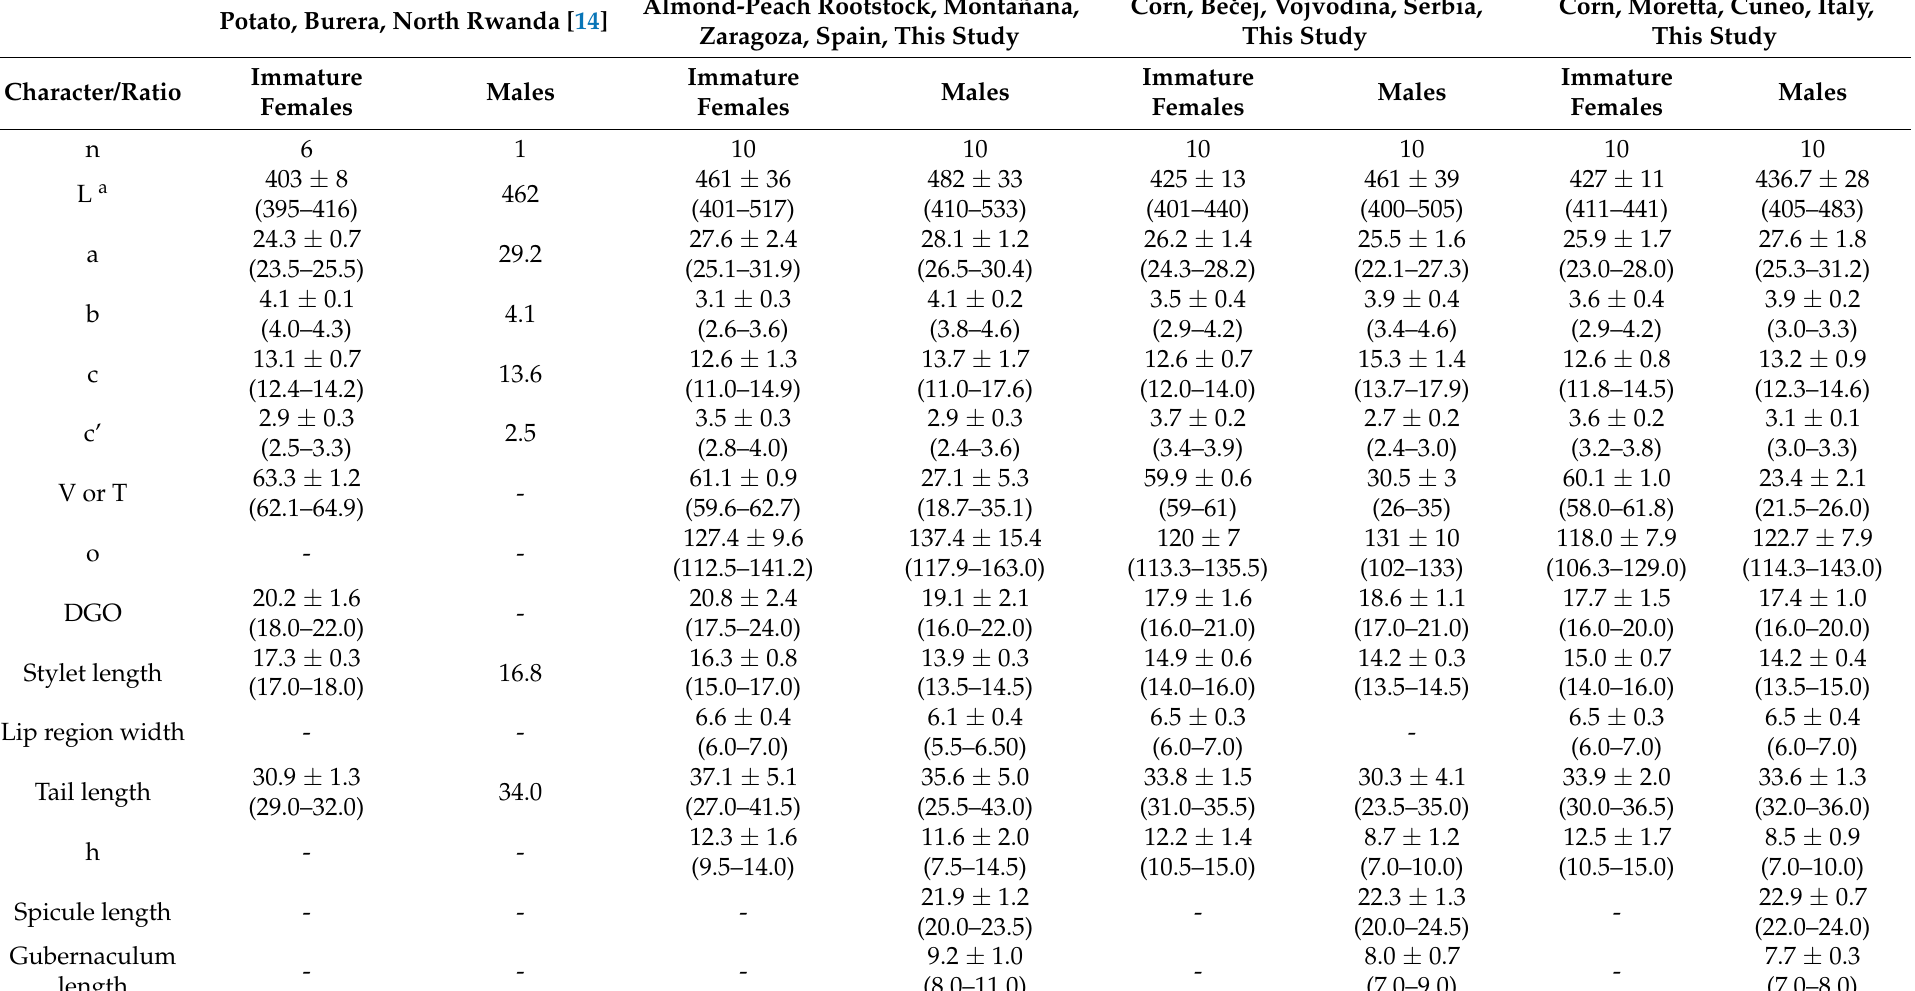
Table 7. Measurements of immature females and males of Rotylenchulus borealis (= R. macrosoma) from potato in Rwanda and almond-peach rootstock and corn from several localities in Europe. All measurements are in micrometers and in the form mean ± SD